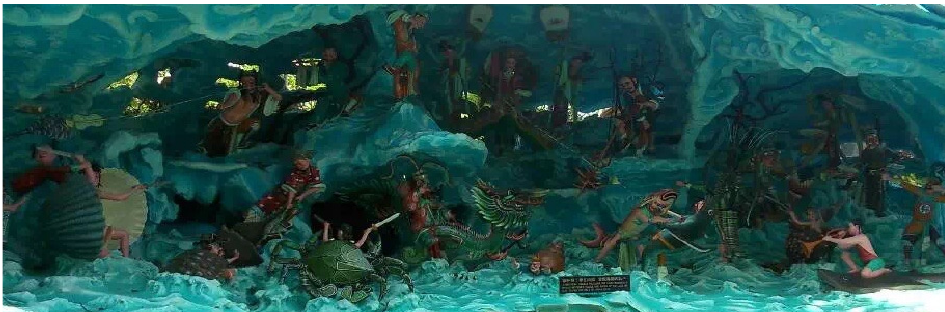
Figure 5. Eight Immortals (dash circled).